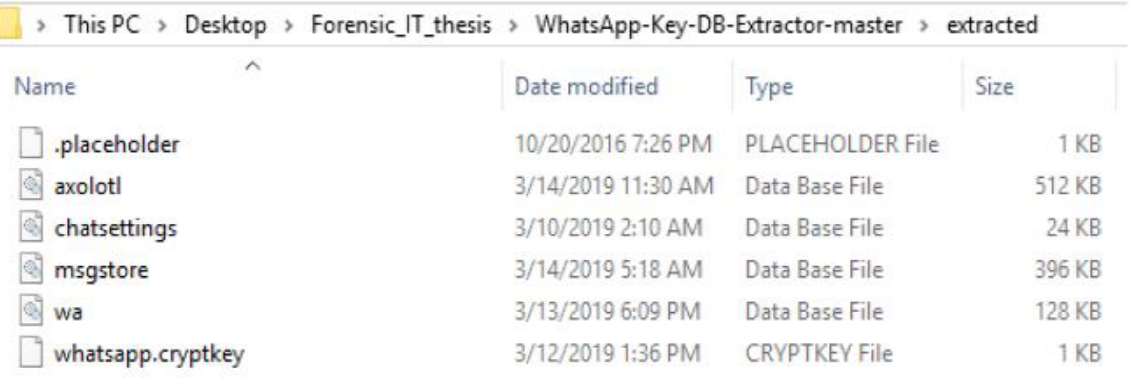
Figure 4. DBs and the key extracted from the